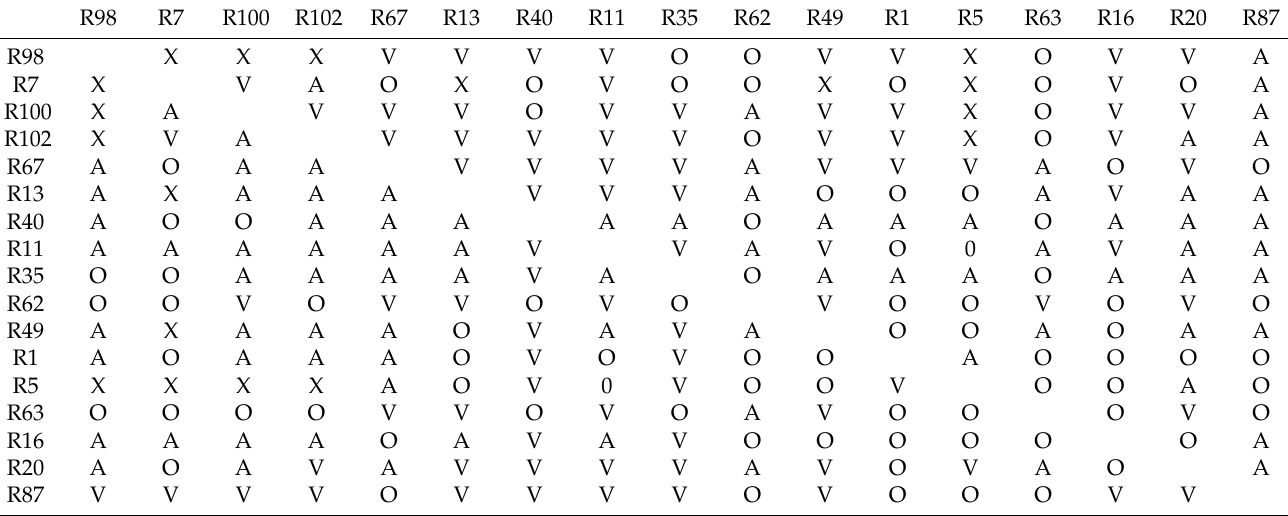
Table 4. Structural self-interaction